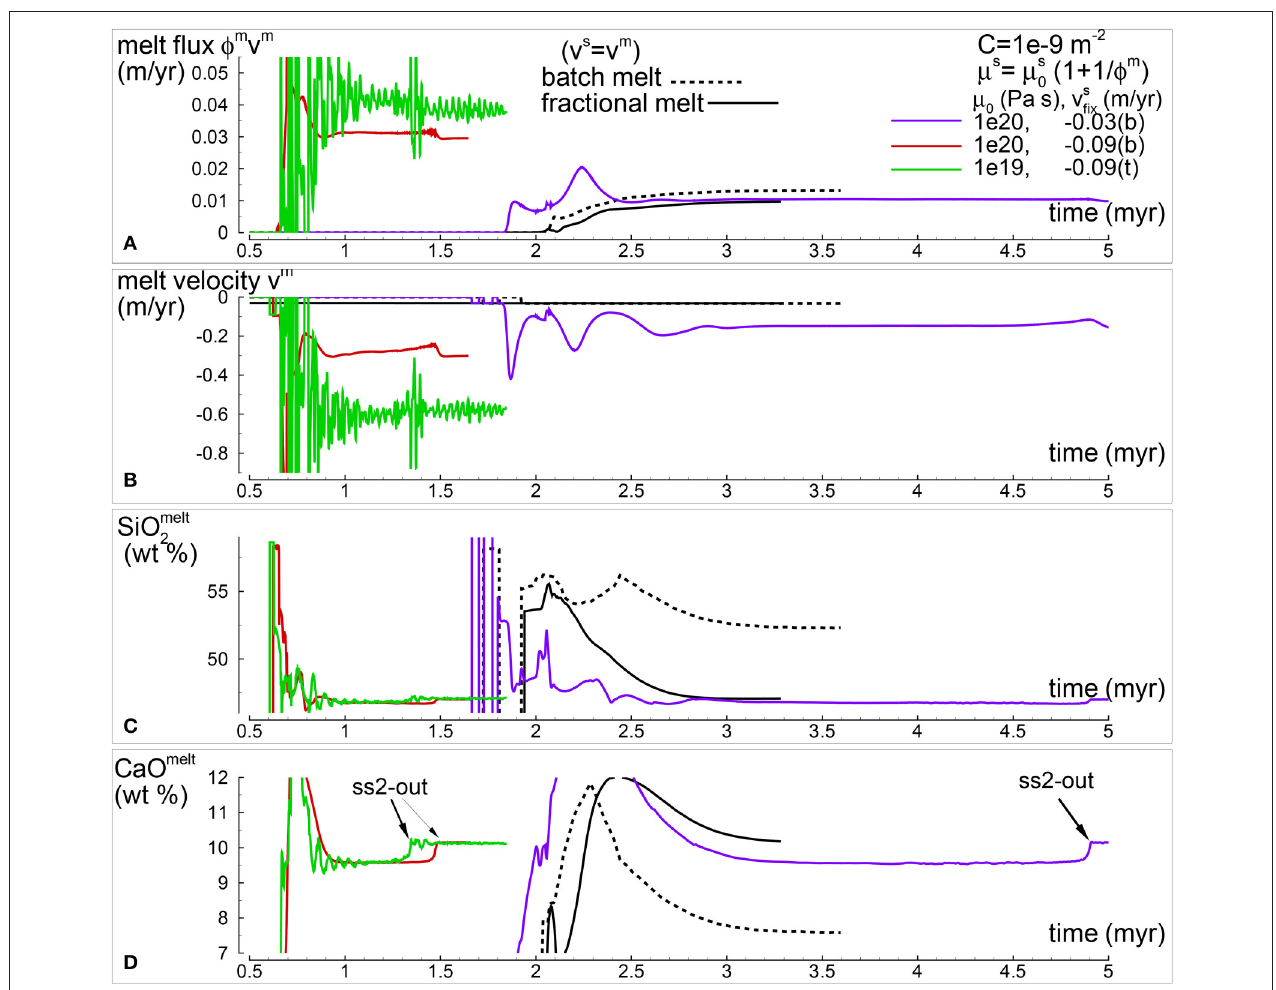
FIGURE 9 | Temporal variation of selected melt properties at the top side of the simulation for three models with µ s = µ s 0 (1 + 1 /φ m ), permeability constant C = 10 − 9 m − 2 and temperature at the bottom T = 1,450 ◦ C. Different lines correspond to simulations with different µ s 0 and velocity of the solid at the top (t) or bottom (b). For comparison simulations of the batch melting model (introduced in the previous study, MF1) and DFM with v s = v m are also included. (A) Melt flux ( φ m v m ). (B) Melt velocity (m/yr). (C) Melt composition: SiO 2 (wt %). (D) Melt composition: CaO (wt %). Complete data can be found in PHASE3-P.BRC4-5.DAT (batch melt v s = v m , zip file max-front1-data.zip in MF1), PHASE3B-P.YRC00.DAT (fractional melt v s = v m , black line), PHASE3B-P2.YRC1.DAT (purple lines), PHASE3-P2.YRC7.DAT (red lines), and PHASE3B-P2.YRC8.DAT (green lines) (all data included in the zip file max-front2-data.zip